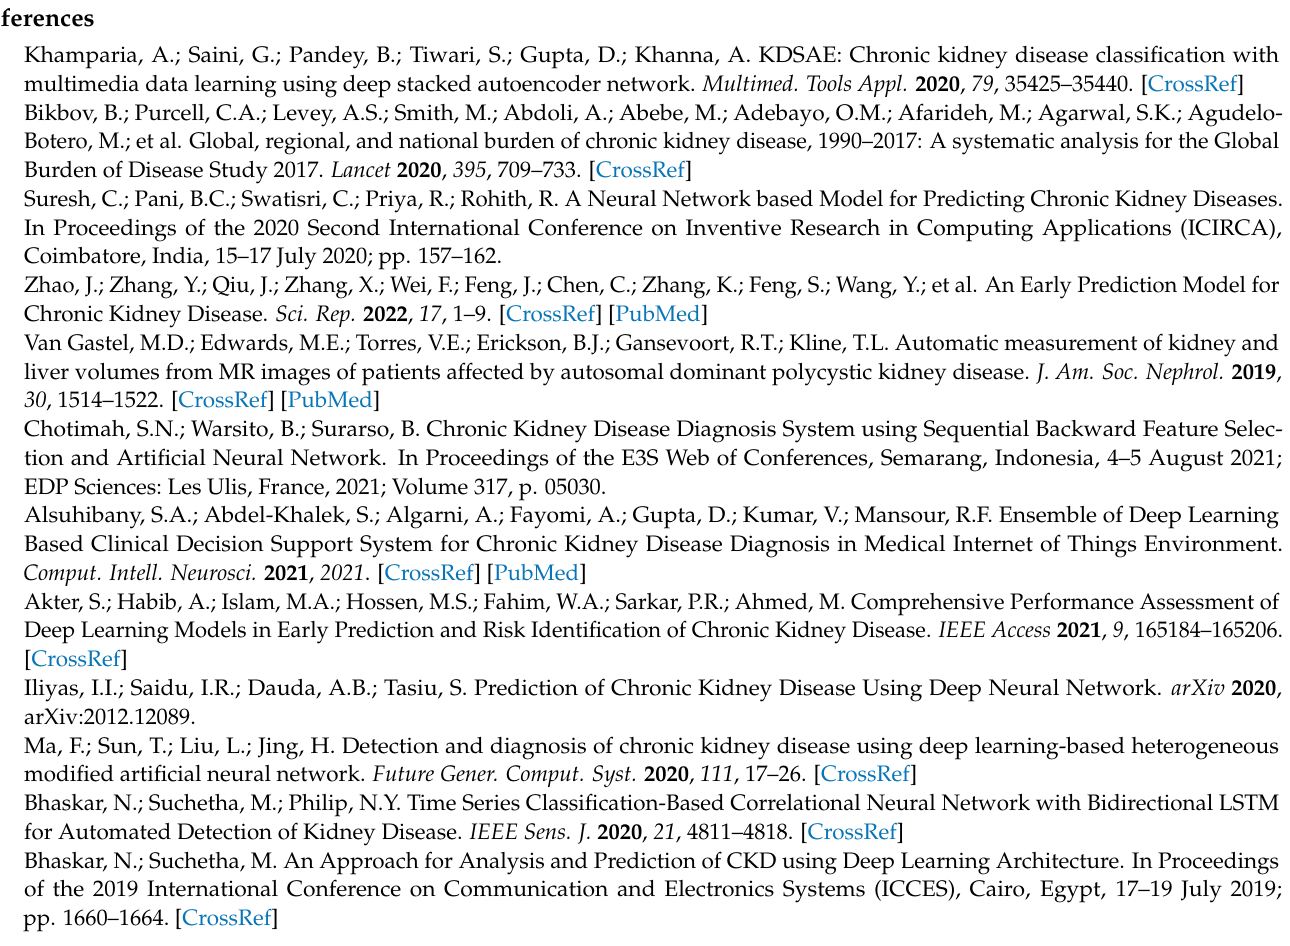
Table S8: Changing dense layers to evaluate the ablation study; Table S9: Changing the activation function to evaluate the ablation study; Table S10: Changing kernel initializer to evaluate the ablation study; Table S11: Changing the optimizer to evaluate the ablation